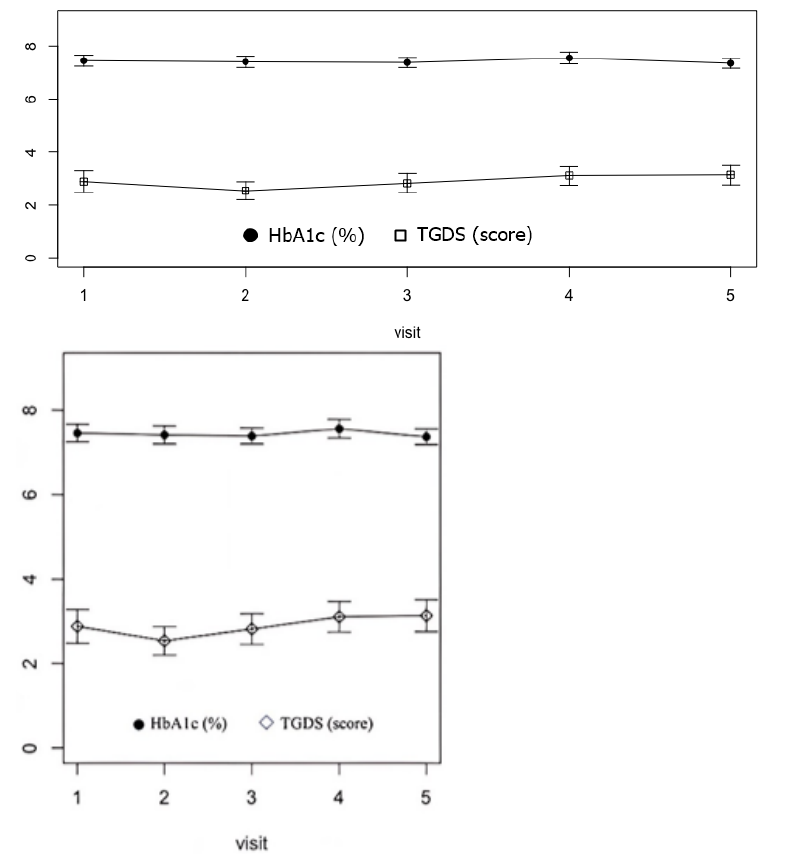
Figure 3. Mean and 95% confidence interval at each time point from visit 1 (T0) to visit 5 of HbA1c and